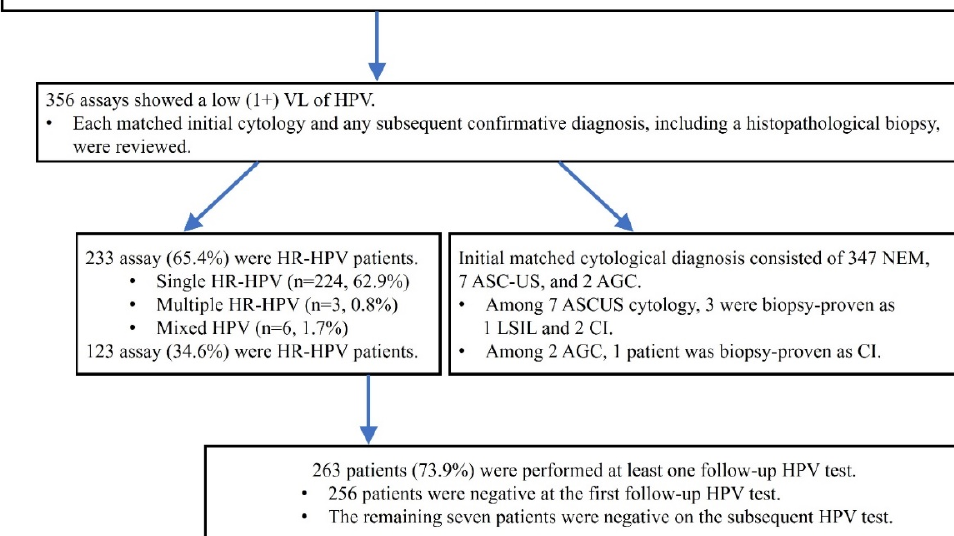
Figure 1. Flowchart of the sample selection and analysis process in this study.